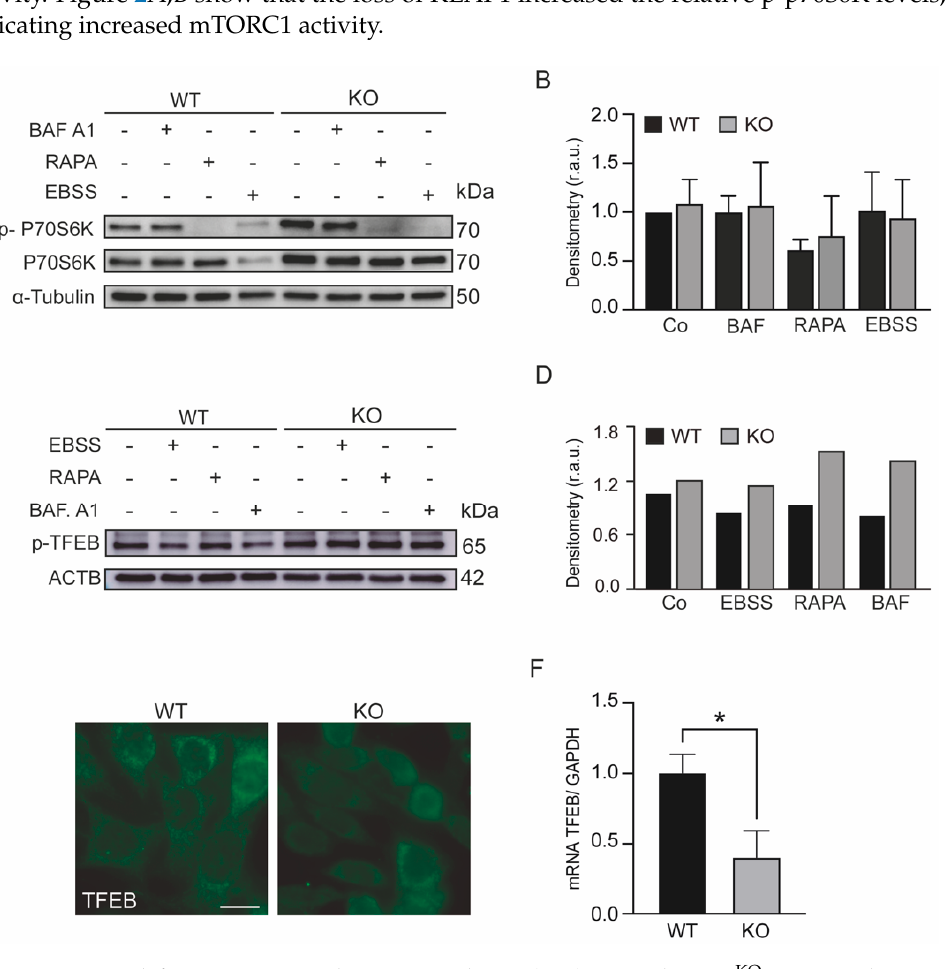
Figure 2. KEAP1 deficiency activates the mTOR pathway. ( A , B ) WT and Keap1 KO mouse embryonic fibroblasts (MEFs) were cultured in control conditions and treated with 1 µM rapamycin (RAPA) or incubated with nutrient-free (EBSS) medium for 4 h. ( A ) p–p70S6K and p70S6K were assessed by immunoblotting. α -tubulin was used as a loading control. ( B ) Densitometry was employed to quan- tify the abundance of p–p70S6K normalized to α -tubulin. ( C , D ) WT and Keap1 KO MEFs were cul- tured in control conditions, incubated with EBSS medium, treated with 1 µM RAPA or incubated with 100 nM Baf. A1 for 4 h. ( C ) p-TFEB was assessed by immunoblotting. ACTB was used as a loading control. ( D ) Densitometry was employed to quantify the abundance of p-TFEB normalized to ACTB. ( E ) Representative immunofluorescence images of cells immunolabeled with TFEB. The scale bar represents 10 µm. ( F ) WT and Keap1 KO MEF RNA were extracted, and real-time quantita- tive PCR was performed for the TFEB gene. GAPDH was used as an endogenous control of gene expression. The histogram shows the means ± SD from at least three independent experiments and they were analyzed using Student’s t -test (* p < 0.05). Next, we analyzed the phosphorylation levels of TFEB using Western blotting and its localization with immunofluorescence. We found that KEAP1-deficient cells showed similar levels of p-TFEB (Ser 142) compared to WT cells, remaining sequestered in the cytosol (Figure 2C–E). Moreover, the mRNA expression level of TFEB was decreased in Keap1 KO cells (Figure 2F). Together, these results indicated that the loss of KEAP1 does not induce lysosomal biogenesis through the mTOR/TFEB pathway. 3.3. Loss of KEAP1 Led to Decreased Cathepsin D Activity Lysosomes contain hydrolytic enzymes that degrade all types of molecules. Cathep- sins are the most abundant lysosomal proteases. Therefore, we studied the effect of KEAP1 deficiency on lysosomal content by analyzing the cathepsin C (CTSC) and D (CTSD) protein levels, and we observed decreased proteolytic cleavage of CTSD from the immature and intermediate forms (52–48 kDa) into the mature form (33 kDa) in Keap1 KO